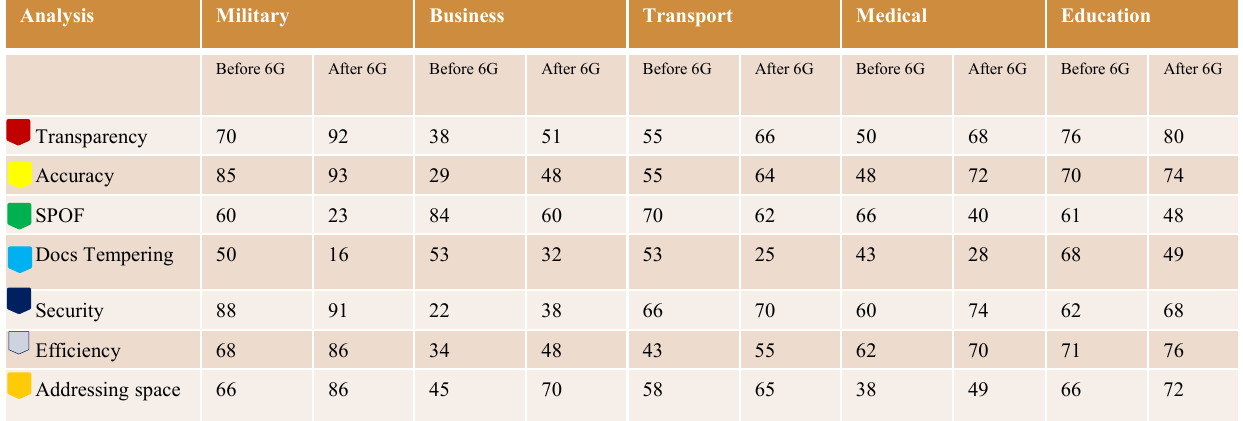
Figure 15. The difference of the results achieved before and after the launch of 6G. For example, when a centralized system was used, transparency was 70 percent and accuracy was 85 percent; however, when blockchain technology was used, transparency was 92 percent and accuracy was 93 percent; SPOF was 60 percent when a centralized system was used but was reduced to 23 percent with blockchain technology; similarly, docs tempering was 50 percent but was reduced to 16 percent with blockchain technology; and 88 percent security was achieved. The same strategy was used in the fields of com- merce, transportation, medicine, and education, as shown in the table. Figure 16 depicts the difference in improvements visually; that is the number of accomplishments that were achieved.